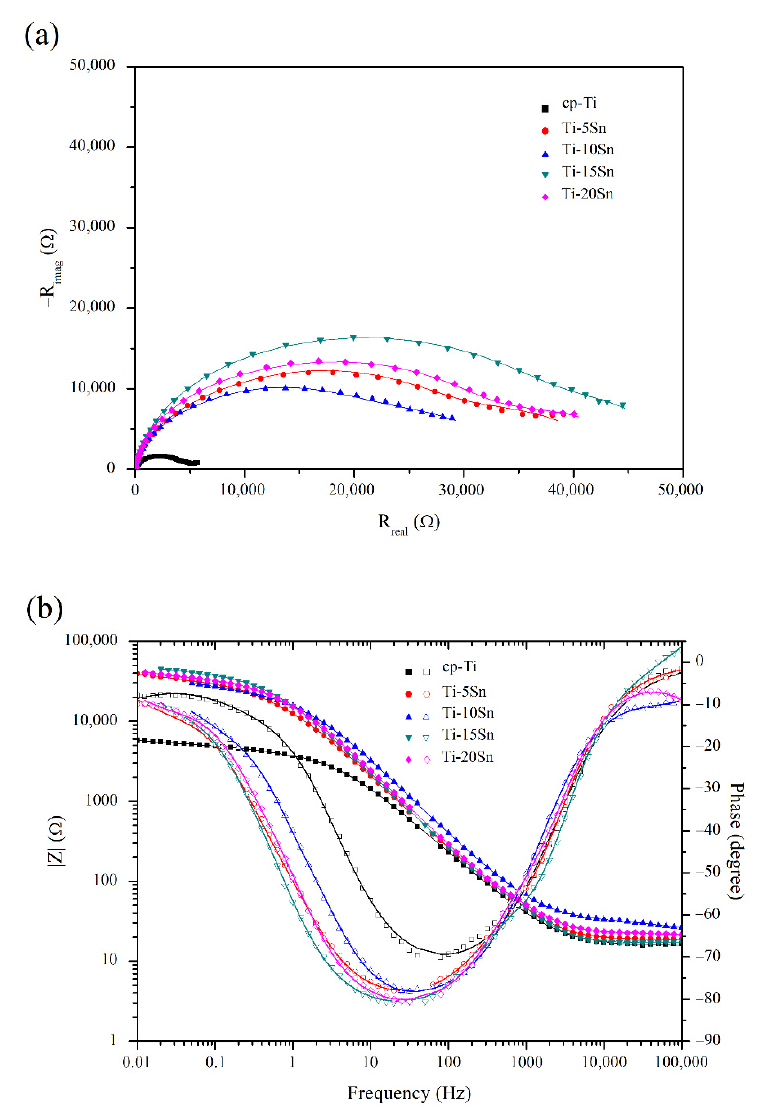
Figure 5. The ( a ) Nyquist and ( b ) Bode impedance curves of cp-Ti and Ti-Sn alloys in the range from 10 6 Hz to 10 − 2 Hz in 0.9% NaCl solution at 37